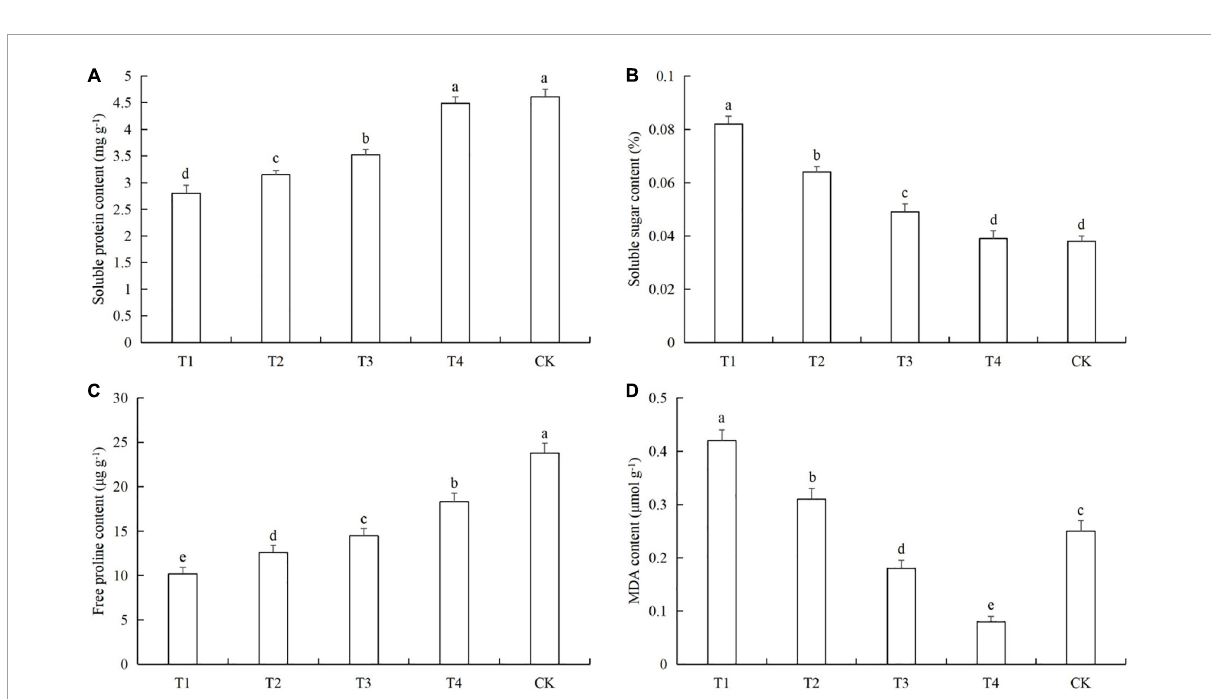
FIGURE4 Effects of the different aphid density treatments on the contents of (A) soluble proteins, (B) soluble sugars, (C) free proline, and (D) malondialdehyde (MDA) in cucumber leaves. T1, 160 aphids; T2, 80 aphids; T3, 40 aphids; T4, 20 aphids; CK, 0 aphids. The mean value ± p < 0.05 error bar data were presented in the figure and different alphabetical letters indicate the significant differences between the aphid density